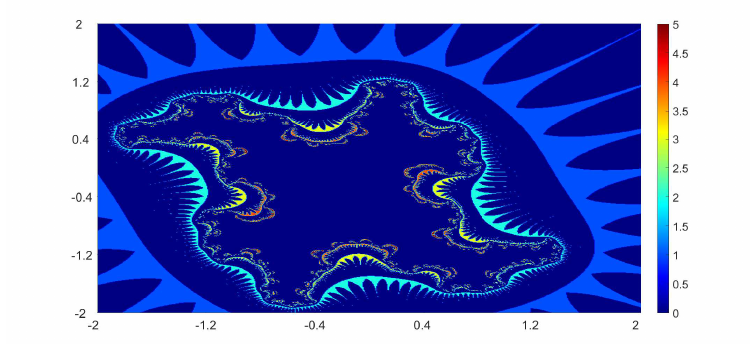
Figure 1. Example